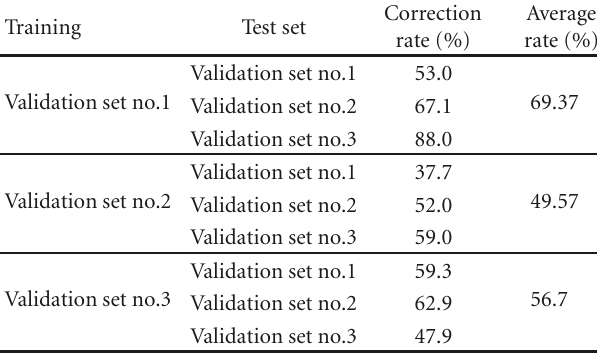
Table 6: 3-fold cross-validation